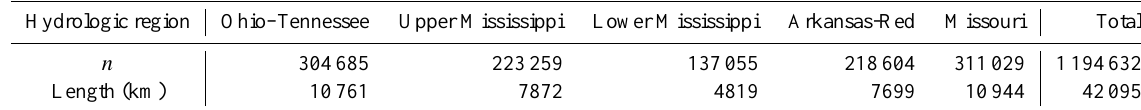
Table 2. Width measurement count and river length.